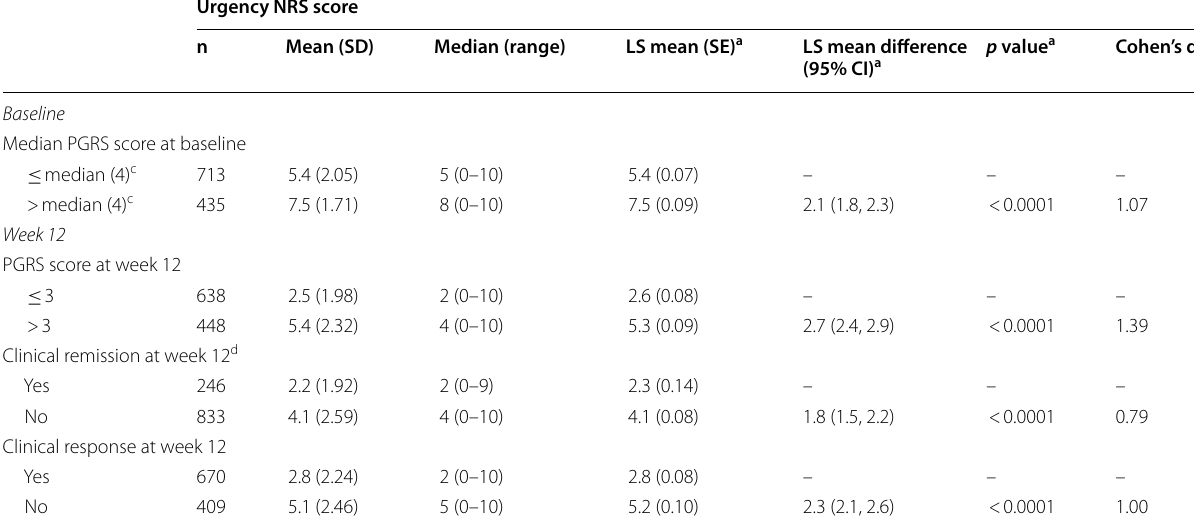
Table 3 Known-groups validity of the Urgency NRS at baseline and Week